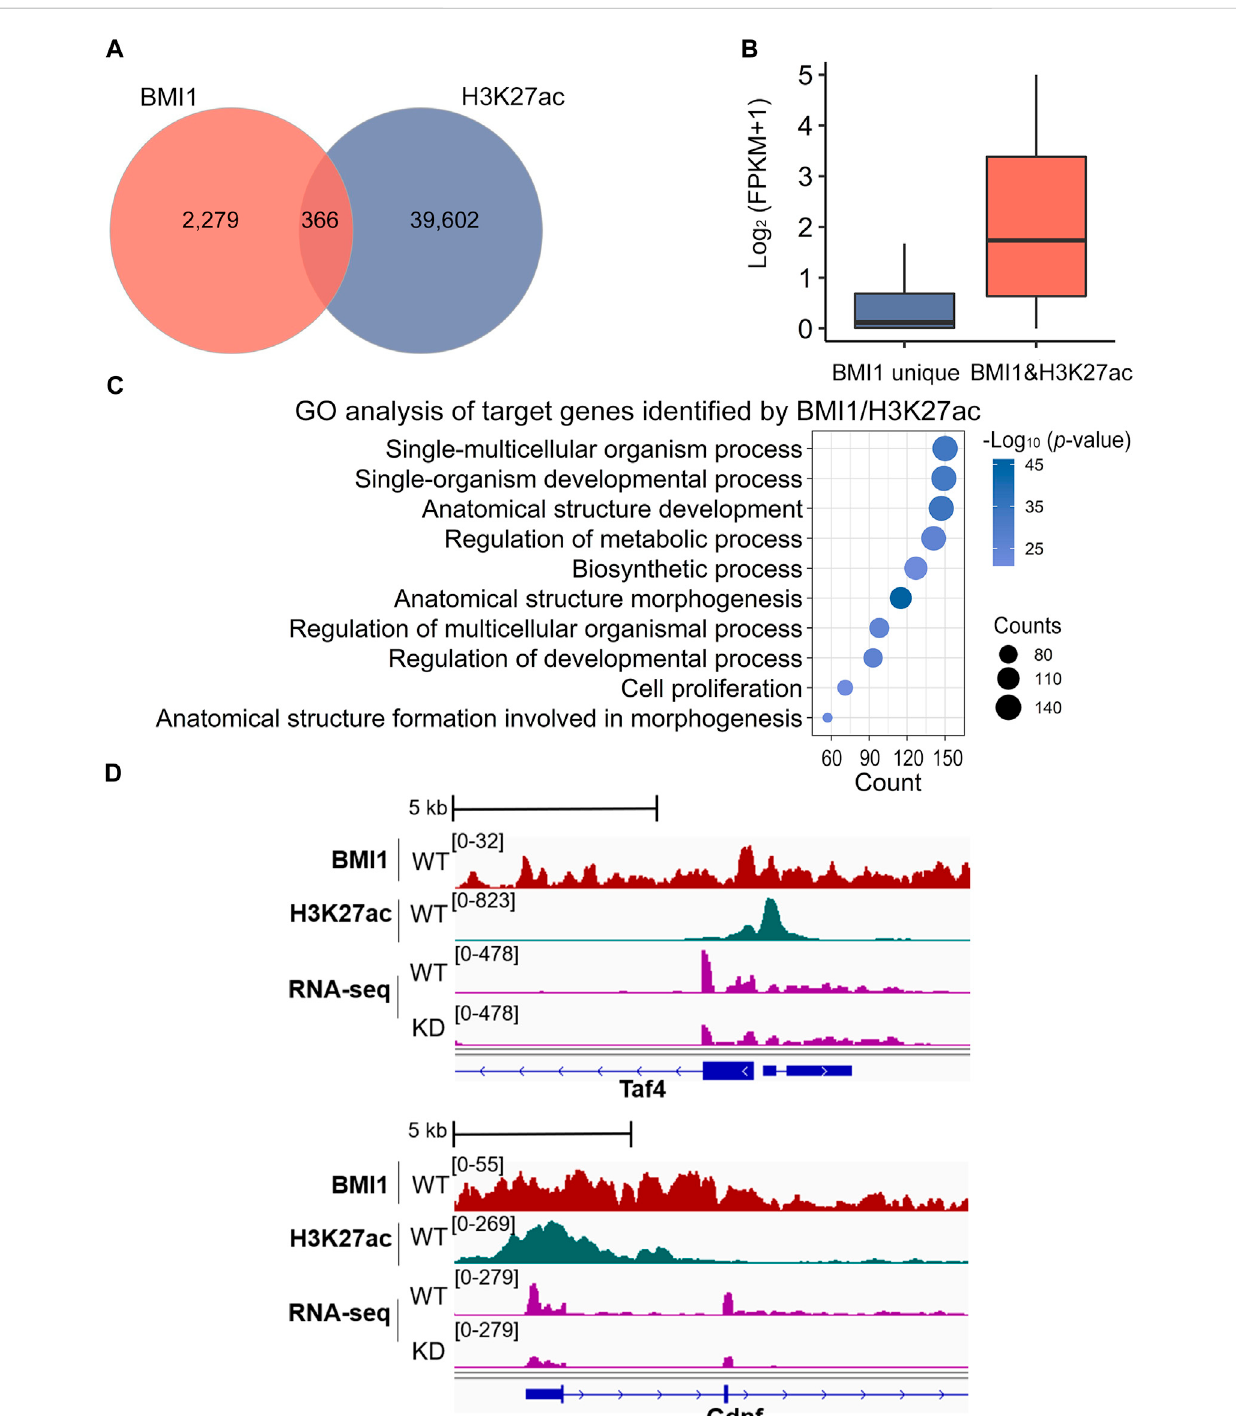
FIGURE 5 BMI1 maintains cell proliferation by H3K27ac modi fi cation. (A) Venn diagram shows the overlap among target regions of BMI1 and H3K27ac. (B) Expression analysis of genes targeted by BMI1 unique and BMI1/H3K27ac. (C) GO analysis of target genes identi fi ed by BMI1/H3K27ac. (D) IGV browser views for BMI1 and H3K27ac at self-renewal and proliferation